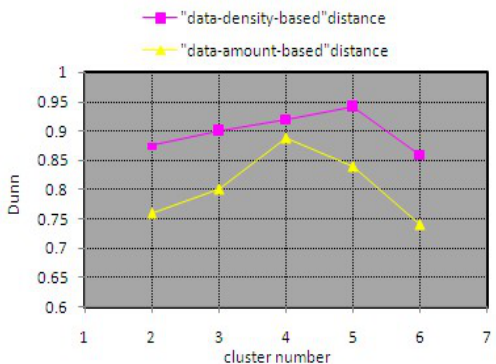
Fig.10. the Dunn value calculated by clustering with data- density-based and data-mount-based distance of Caribou